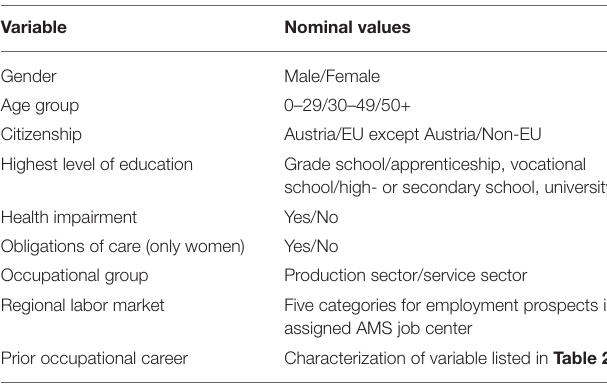
TABLE 1 | All variables that are part of the statistical model.